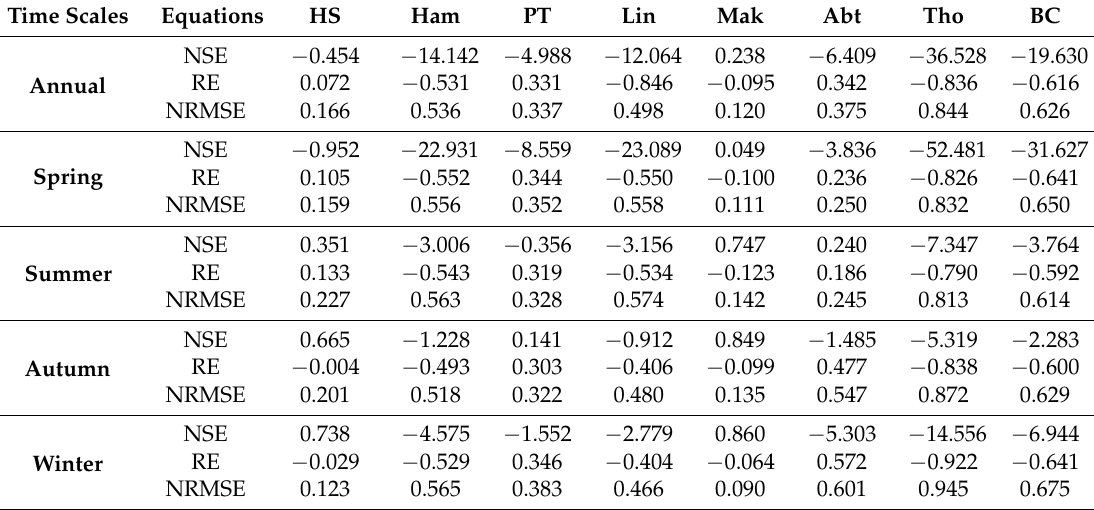
Table 5. Accuracy assessment of PET estimation in the eastern margin of the Tibetan Plateau.